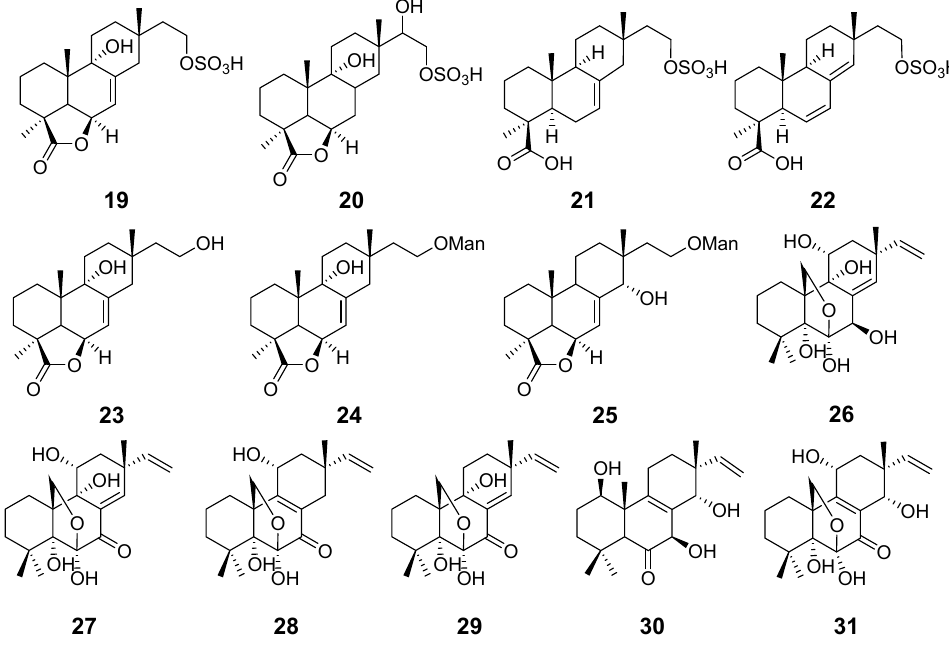
Figure 3. Structures of compounds 19 – 31 .